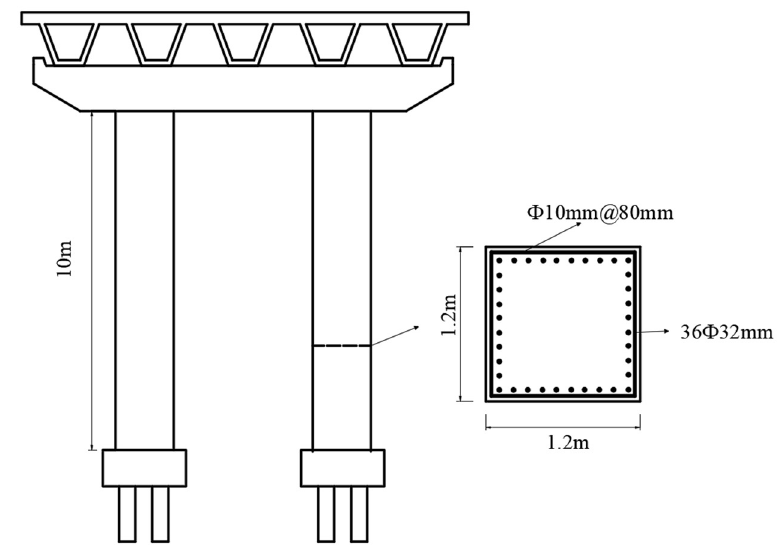
Figure 9. Schematic diagram of pier and its section.